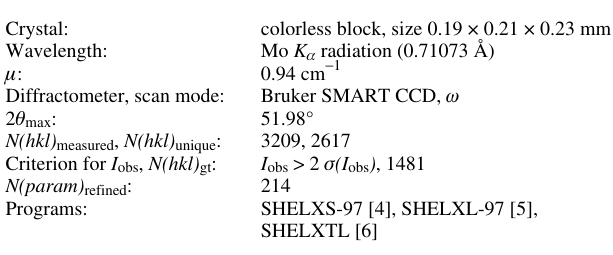
Table 1. Data collection and handling.